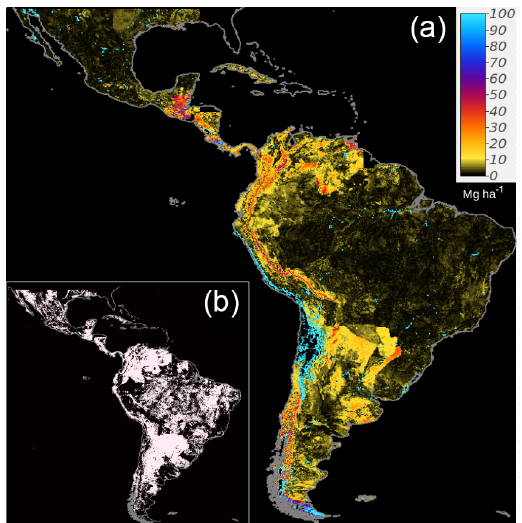
Figure 7. The absolute distance (Mgha) between the country- specific and the regional ensemble (a) . The areas in white are ar- eas where the country-specific modeling is predicting higher SOC than the regional estimate (i.e., country-specific is greater than re- gional) (b) .